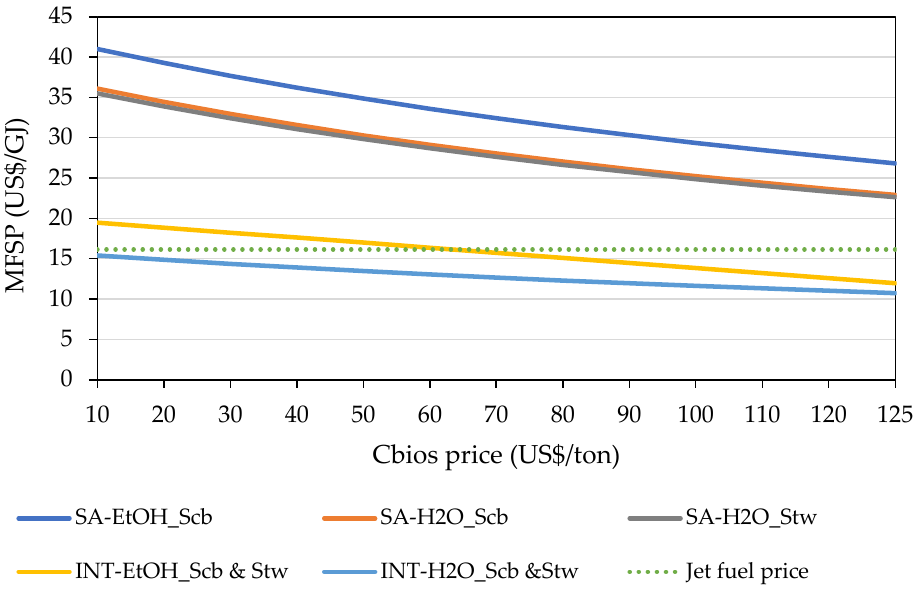
Figure 5. Influence of Cbios price on the MFSP of sustainable aviation fuel.